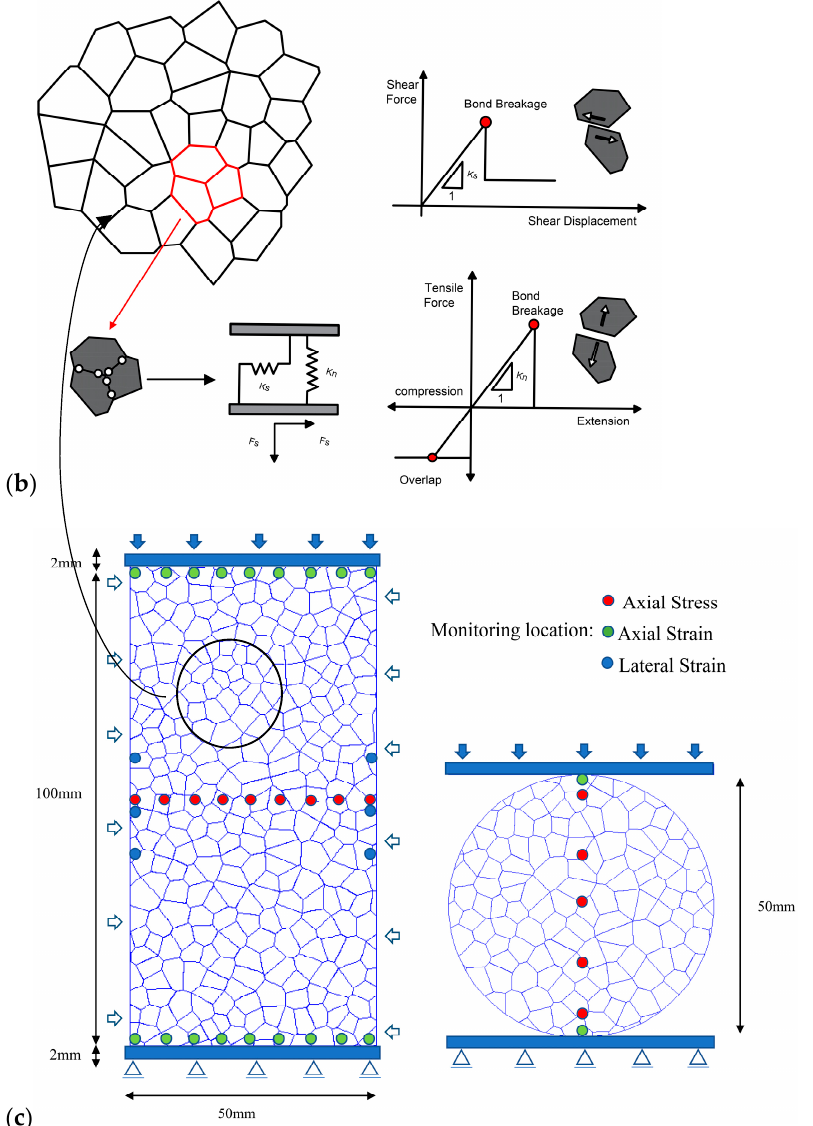
Figure 1. ( a ) Voronoi tessellation generator logic and natural mineral grain structure in rock (modified from [29,43]); ( b ) constitutive behavior of Voronoi model (modified from [44]) Note: The normal force ( F n ) is controlled by the normal stiffness ( k n ), and the shear force ( F S ) is controlled by the shear stiffness ( k s ); ( c ) numerical models of uniaxial/triaxial compressive and Brazilian split tests. The Voronoi polygon blocks are assigned an isotropic elastic deformable material model, which means that failure on the micro-scale only takes place at the block boundaries, not inside them. The mechanical properties of the connection between Voronoi polygon blocks obey the Coulomb friction law. Normal stiffness, shear stiffness, cohesion, friction, and tensile strength can be assigned to the contacts. These properties are referred to as the micro-properties. The Voronoi micro-mechanical behaviors and properties are shown in Figure 1 and Table 1.